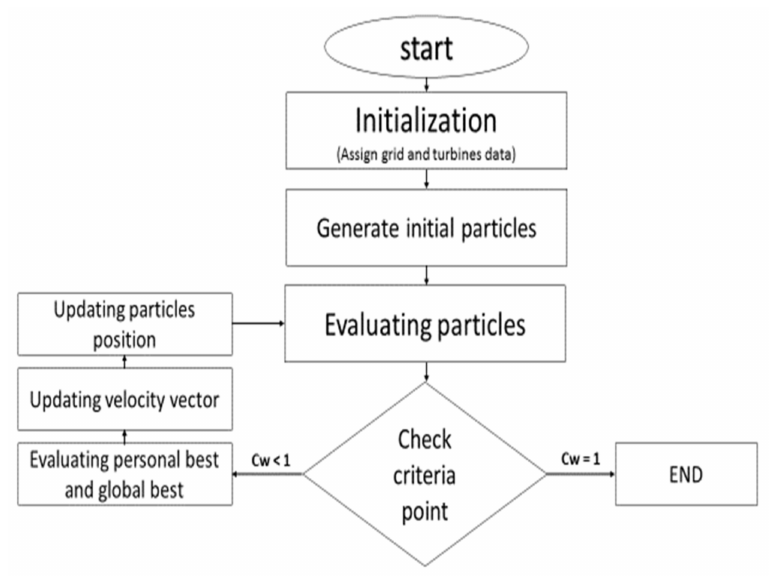
Figure 6. Particle swarm optimization (PSO) Flowchart.